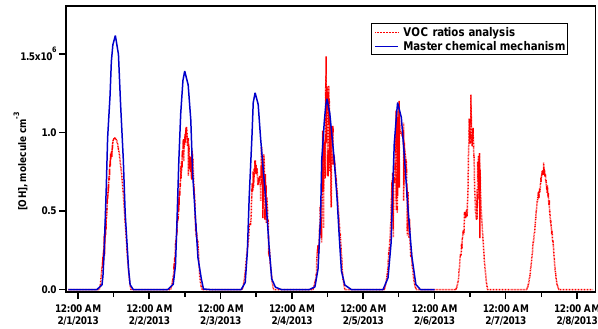
Figure 7. Comparison of OH with the Master Chemical Mechanism prediction. There is good agreement between the MCM OH and OH determined from our